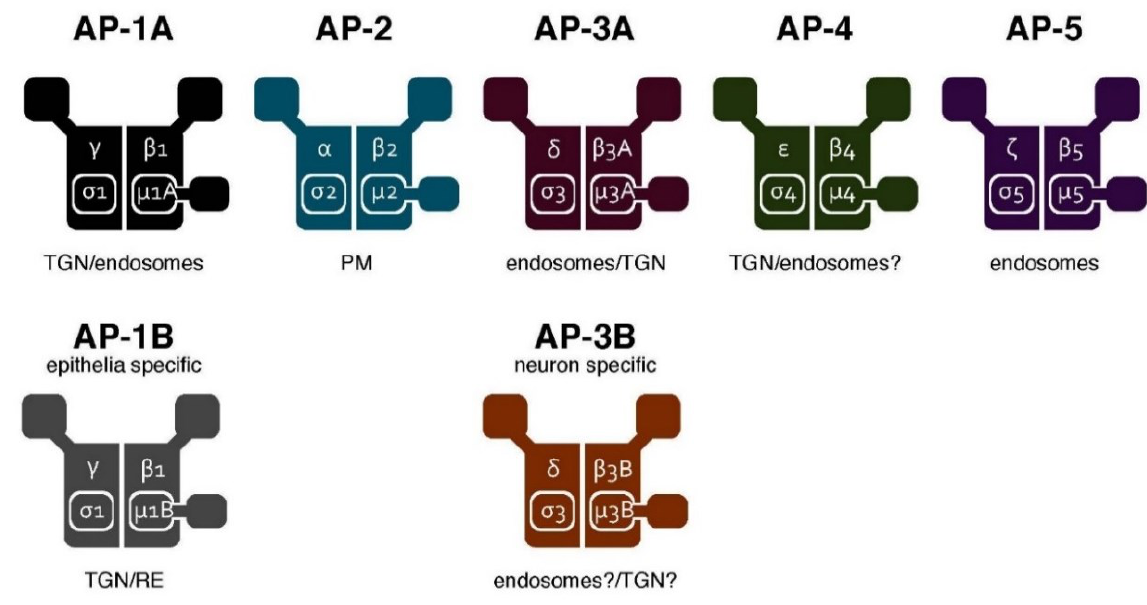
Figure 1. The AP complexes. Schematic representation of the AP complex family. Seven AP complexes have been identified to date. They share the overall composition of the constituting subunits: two large subunits, one medium subunit and one small subunit. The five complexes depicted at the top (AP-1A, AP-2, AP-3A, AP-4 and AP-5) are widely expressed, whereas the two complexes shown at the bottom (AP-1B and AP-3B) are expressed in a tissue-specific manner. They localize to distinct, yet partially overlapping, organelles. The organelle membrane at which each complex is localized (for controlling protein sorting) is shown below the complex. TGN, trans-Golgi